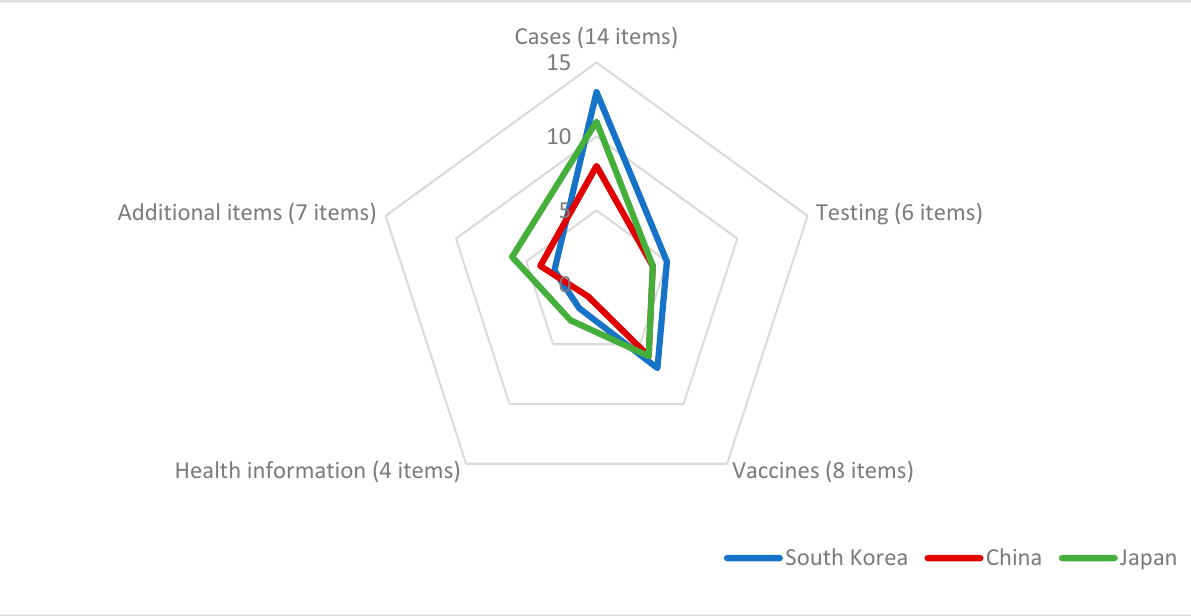
Figure 5. Performance of information disclosure on the COVID-19 dashboard in South Korea, China, and Japan.